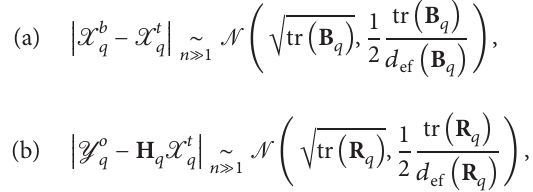
Direct consequences of the concentration of Gaussian law in high dimensions are that according to